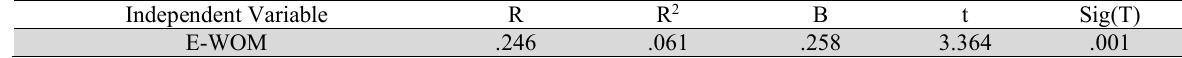
Simple Linear Regression for Examining the Effect of Viral Advertising on Customer Purchase Intention Independent Variable R R 2 B t Sig(T) Viral Advertising .335 a .112 .360 4.698 .000